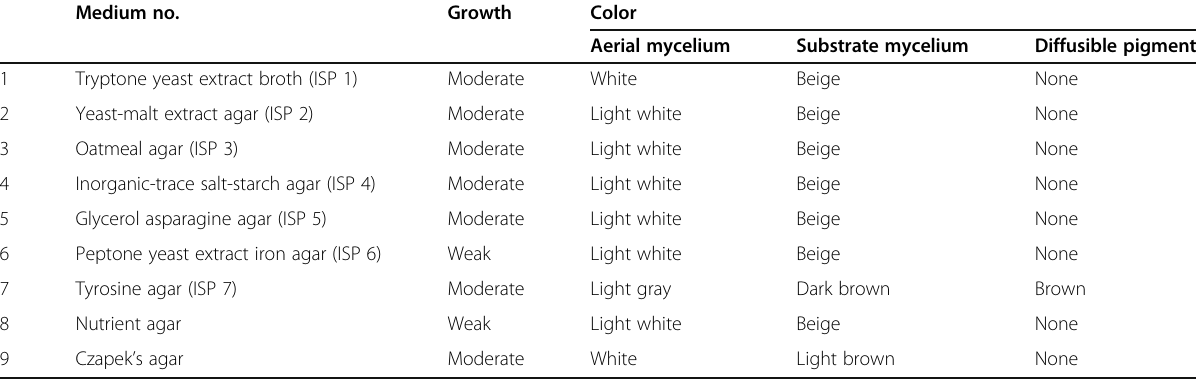
Table 1 Cultural characteristics of the Streptomyces sp. SBLWN_MH2 at 14 and 21 days Medium no.